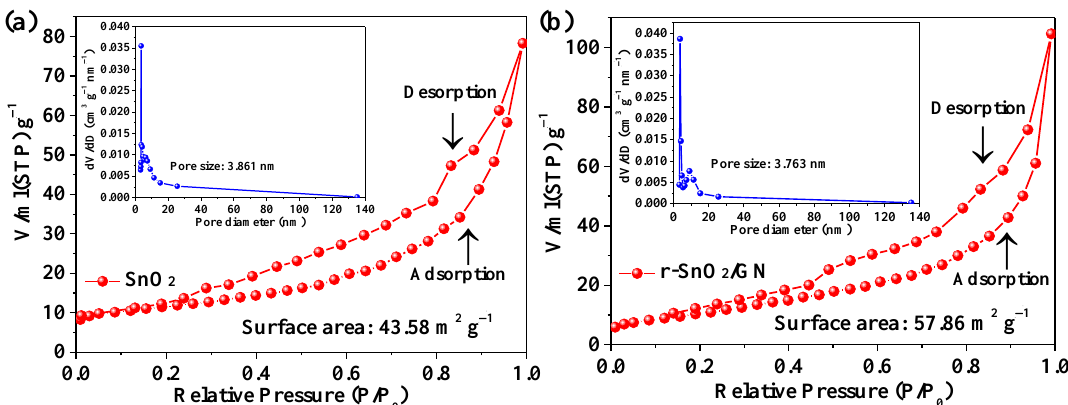
Figure 4. N 2 adsorption/desorption isotherms of two samples ( a ) SnO 2 and ( b ) r-SnO 2 /GN; the inset is the pore size distribution.